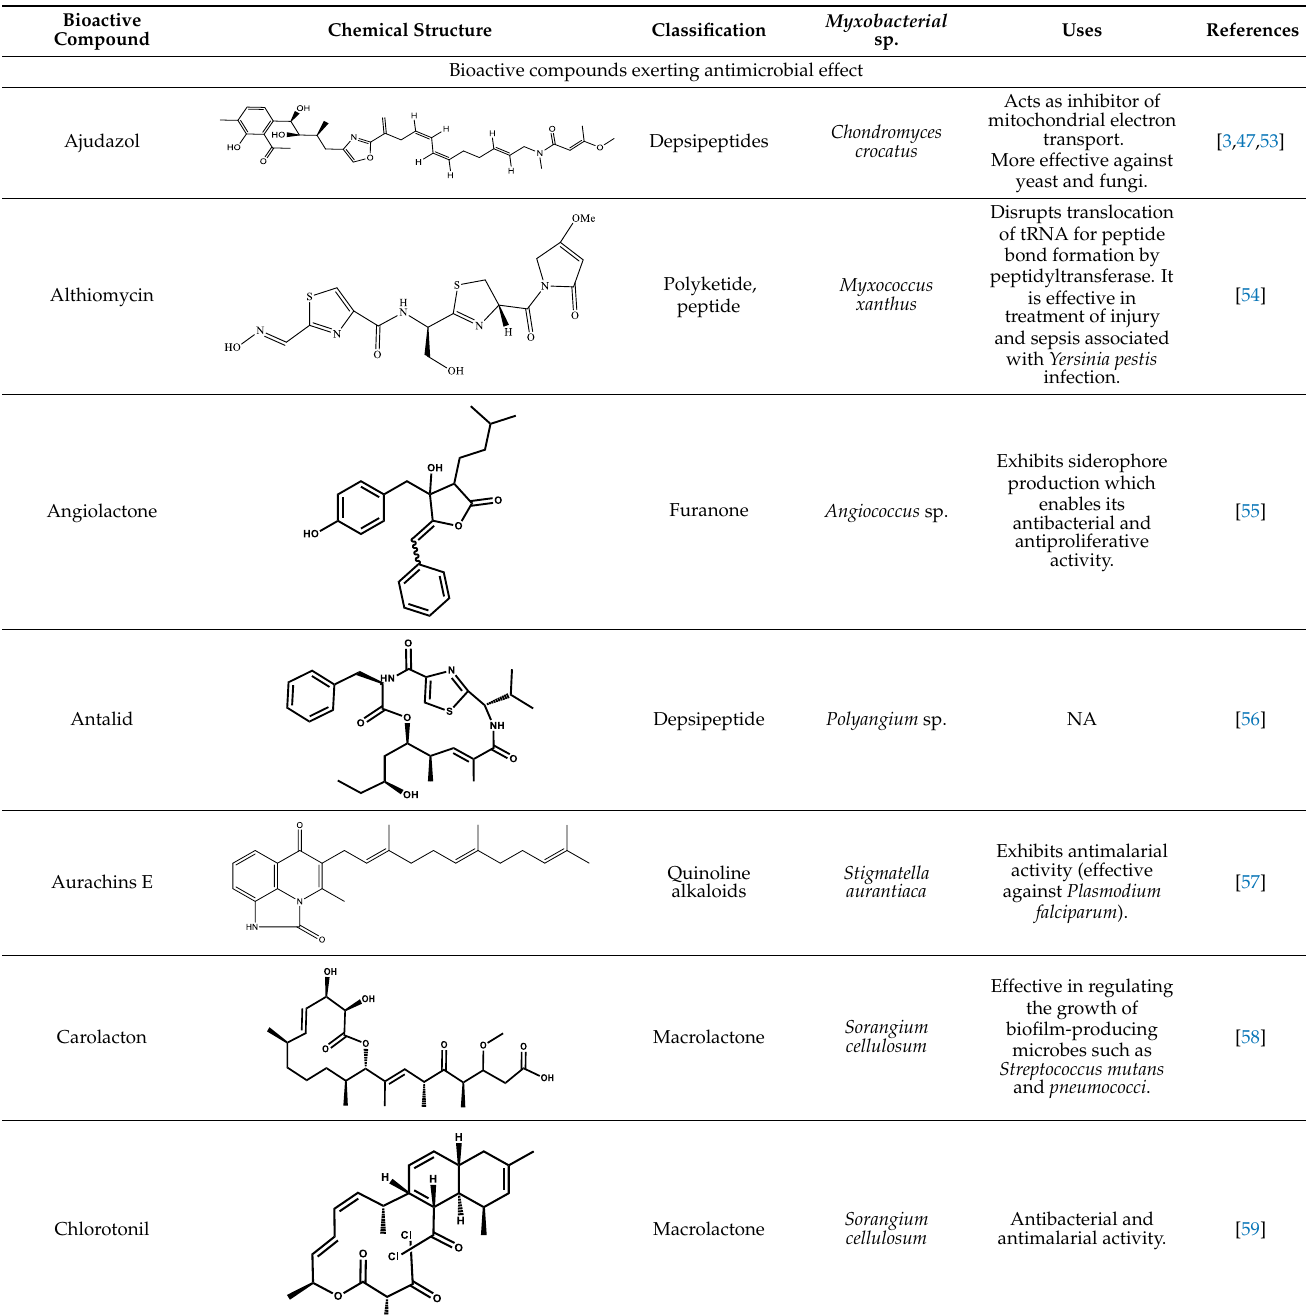
Table 1. Categorization of Myxobacterial- derived secondary metabolites based on their function.